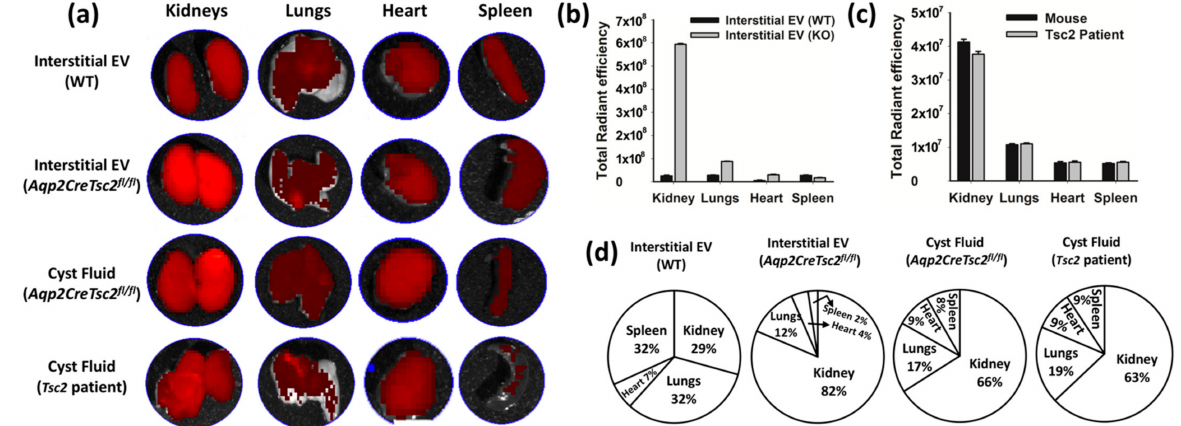
Figure 3. Ex vivo tissue distribution of Dir-labelled extracellular vesicles derived from mouse and human; 1.67 × 10 9 EV per kilogram body weight were intraperitoneally injected for four hours followed by tissue excision and imaged using Perkin Elmer imaging system. ( a ) Imaging reveals the migration of EV to the kidney, lungs, heart, and spleen. ( b , c ) Representation of average radiant efficiency in different organs (kidney, lungs, heart, and spleen) after the introduction of EVs derived from interstitial and cyst fluid isolated from the kidney of Aqp 2CreTsc2 fl/fl and Tsc2 patients. Note that due to image processing (flattening), the lung signal is actually greater than the heart. ( d ) Representation of migration of various EVs in different